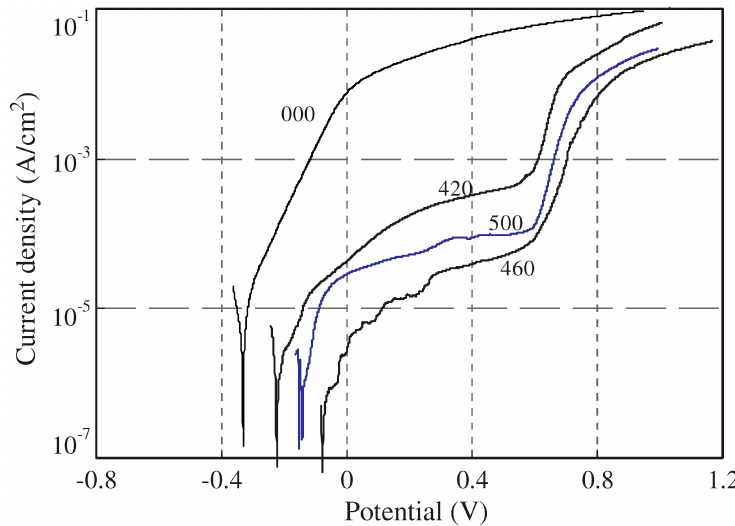
Figure 8. Polarization curves of untreated (000) and plasma nitrided (420, 500 and 460, where the number indicates the temperature of the nitriding process) 410 stainless steel in 3.5 wt % NaCl water solution (un-deaerated, unstirred) (adapted from [85] with permission of Elsevier).